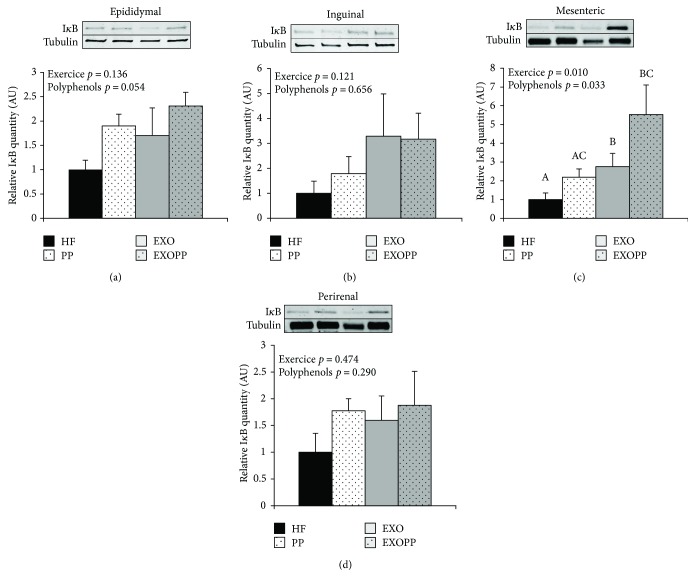
IκB levels in fat stores. IκB protein expression levels were measured by immunoblotting in epididymal (a), inguinal (b), mesenteric (c), and perirenal (d) fat stores. Quantification values are presented as IκB protein levels normalized to tubulin protein level, used as protein loading control, and are expressed relative to HF group's values, which were set at 1. Data are expressed as mean ± SEM with n = 5 − 6 rats per group. Bars not sharing a common letter are significantly different at p < 0.05.